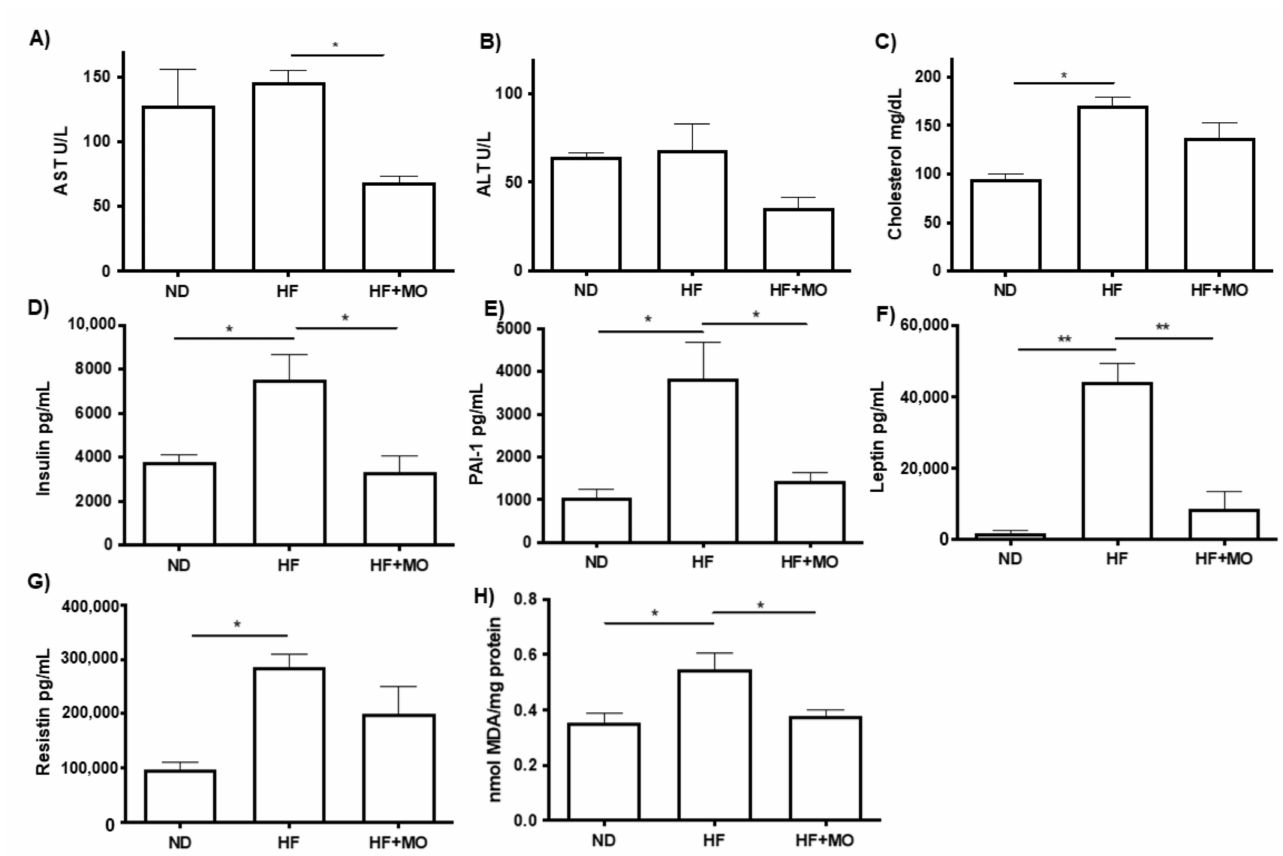
Figure 2. Supplementation of Moringa improves biochemical hepatic test, adipokines serum levels and lipid peroxidation. ( A , B ) Hepatic enzymes showed reduction in Mo group, especially AST ( p < 0.05). ( C ) Cholesterol serum levels did not show statistical difference between HF and Mo groups. Serum adipokines ( D ) Insulin, ( E ) Plasminogen activator inhibitor-1, ( F ) Leptin and ( G ) Resistin decreased in Mo animals ( p < 0.05 and p < 0.01). ( H ) MDA hepatic levels indicated a reduced lipid peroxidation in animals treated with Mo. Data are expressed as mean ± SE. * p < 0.05; ** p < 0.01. The serum levels of insulin, resistin, leptin and PAI-1 are significantly in- creased in the HF groups compared to the control group (Figure 3D–F). Noteworthy, insulin (7505 pg/mL ± 943.1 vs. 3335 pg/mL ± 889.2; p < 0.05, Figure 2D), PAI-1 (3824 pg/mL ± 867.2 vs. 1425 pg/mL ± 209.3; p < 0.05, Figure 2E) and leptin serum levels (44,373 pg/mL ± 5129 vs. 8718 pg/mL ± 4872; p < 0.01, Figure 2F) were significantly lower in the HF + MO group compared to the HF group. Serum levels of resistin (Figure 2G) did not show significant changes in the group treated with Moringa, though a tendency to decrease was